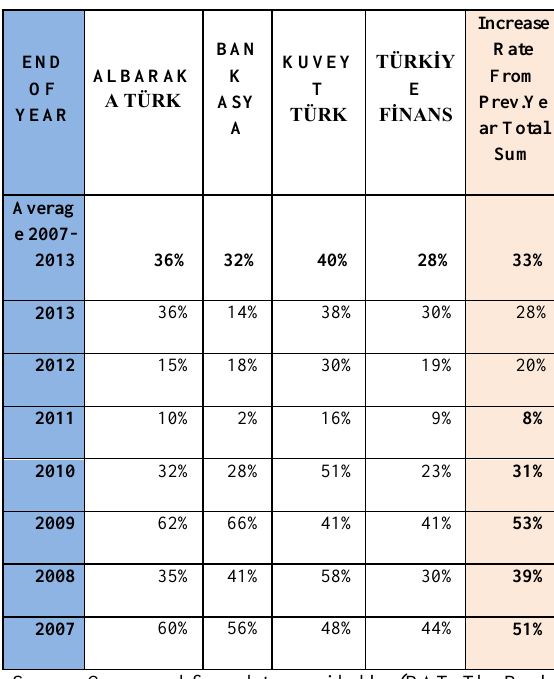
Table-6/b: Increase Rate from Previous Year at Collected Turkish Currency Funds in Participation Banks, 2007-2013 (1000TL)